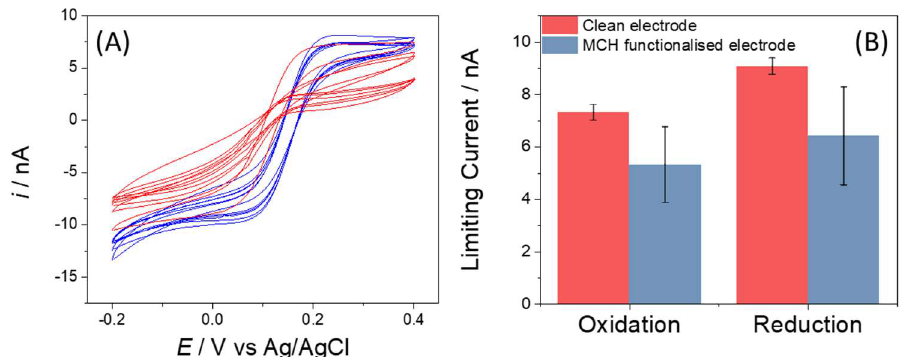
Figure 4. ( A ) Cyclic voltammogram from bare electrodes (blue) and following functionalization with 6 mercapto-1-hexanol (red). ( B ) EIS response from bare electrodes (blue) and following functionalization with 6 mercapto-1-hexanol (red). N = 6 and error bars represent standard deviation.